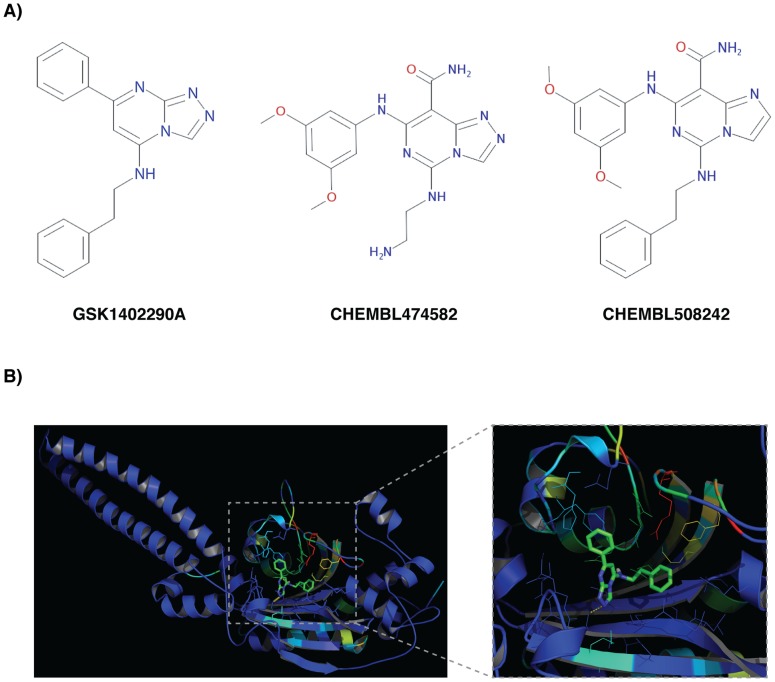
Targeting the aminoacyl-tRNA biosynthesis pathway.
A) CHEM results show that GSK1402290A shared several substructural features with compounds reported as potent lysyl-tRNA synthetase inhibitors in the ChEMBL database (e.g., CHEMBL474582 and CHEMBL508242). B) STR results predicted the serS as a target of GSK1402290A with its binding site including residues F205, H209, G225, T226, E228, R257, F276, K278, and E280, which are conserved in the PFAM family PF00587 (tRNA synthetase class II core domain). Zoomed image shows the pose for GSK1402290A predicted by AutoDock and the binding site residues (i.e., within 6 Å from the compound) coloured from low sequence conservation (blue) to high sequence conservation (red).